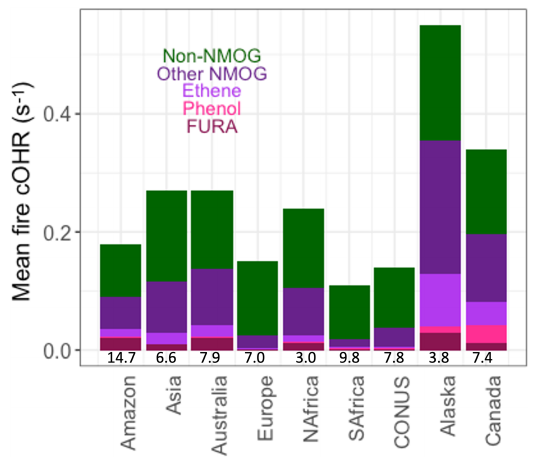
Figure 10. Mean simulated surface fire cOHR in 2019 us- ing GFED4s DM regionally for the Amazon, Asia, Australia, Europe, northern hemispheric Africa (NAfrica), southern hemi- spheric Africa (SAfrica), the contiguous US (CONUS), Alaska, and Canada. Numbers at the bottom of each bar are the 1997–2016 area- averaged burned area (in millions of square kilometers) from van der Werf et al. (2017). See Fig. S9 for the same analysis with the standard